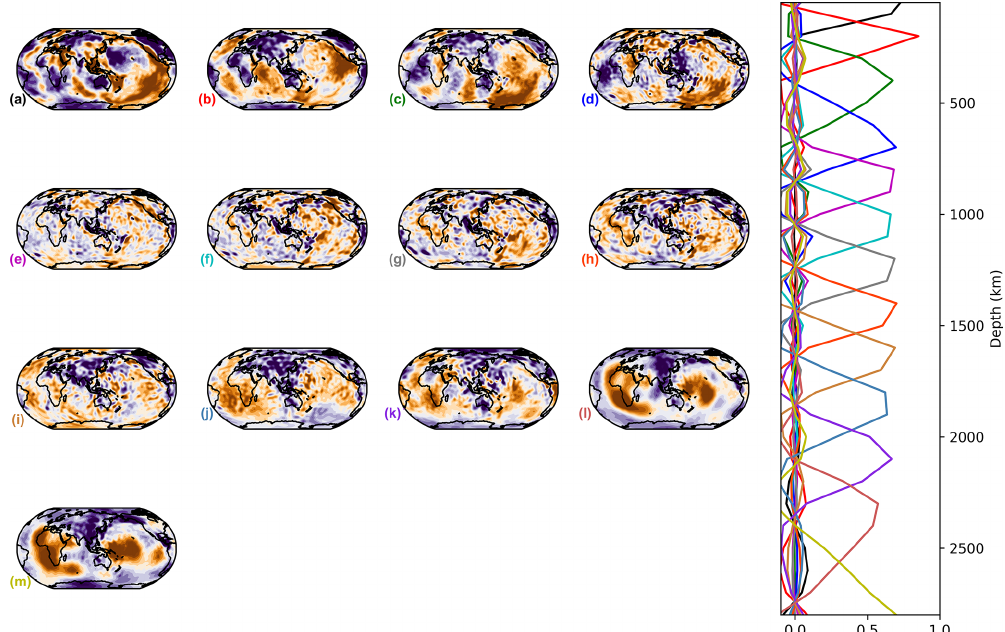
Figure C6. The 13 varimax components of the isotropic part of the SEISGlob2 model.